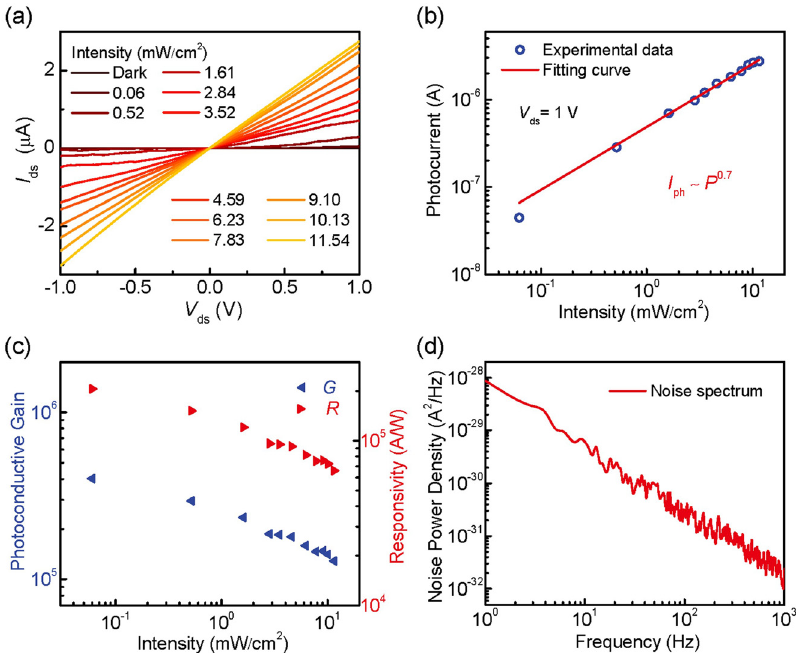
Figure 4: Photoresponse properties and noisepower densityspectra of ferroelectric side-gated single SnS 2 NW